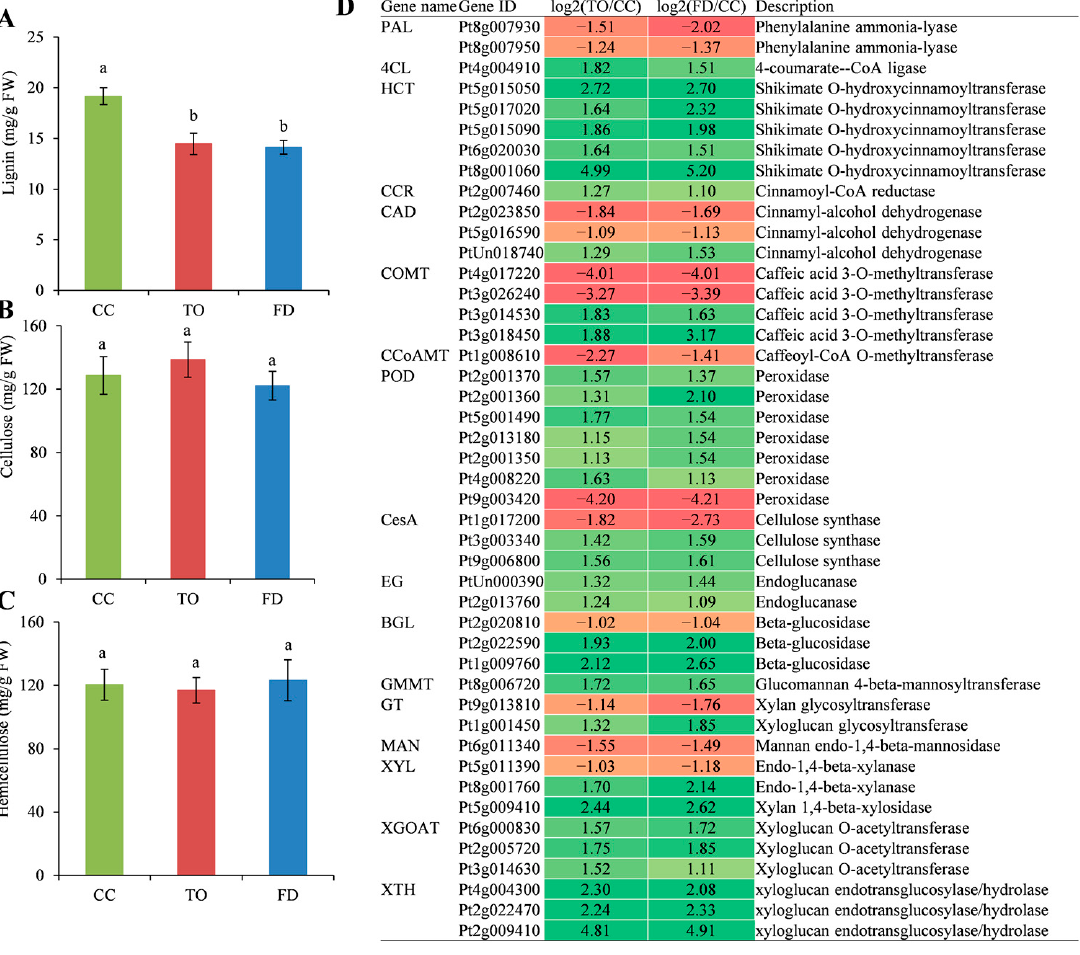
Figure 6. Changes in the content of lignin ( A ), cellulose ( B ), hemicellulose ( C ), and their metabolism-related gene expression ( D ). Different small letters indicate significant differences at p < 0.05 according to Duncan’s multiple range tests.